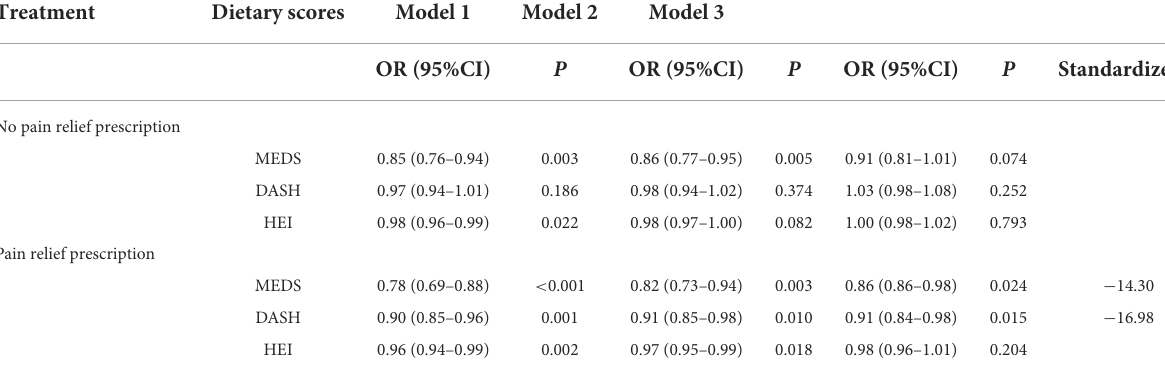
TABLE 7 Association analysis of dietary scores and depression in whether use pain relief prescription subgroup.